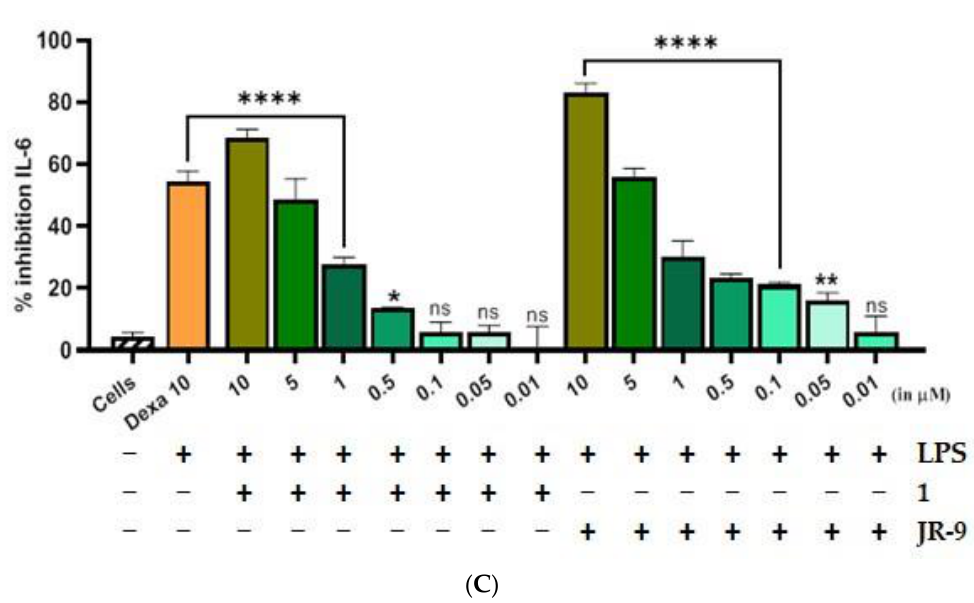
Figure 3. Comparative effect of 1 and JR-9 on ( A ) NO, ( B ) TNF-α, and ( C ) IL-6 release in LPS stimulated RAW 264.7 cells. The cells were treated with different concentrations of 1 and JR-9 for 1 h, and LPS (1 µg/mL) was then added for 24 h. The levels of nitric oxide in the cell culture supernatant were measured using the Griess reagent assay, and the levels of TNF-α and IL-6 in the cell culture supernatant were measured using ELISA. All values were mean ± SD, n = 3. (**** p < 0.0001, *** p < 0.0005, ** p < 0.005, * p < 0.05) indicated a significant difference with the LPS-treated cells assessed by one-way ANOVA followed by Dunnett’s test. L-NAME: L-NG-Nitro arginine methyl ester; LPS: lipopolysaccharide; Dexa: dexamethasone; TNF-α: tumor necrosis factor-alpha; IL-6: interleukin-6.